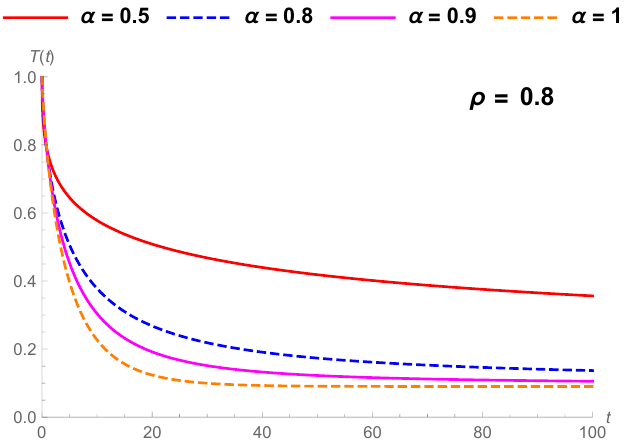
Figure 5. Comparison of drying kinetics with Lewis generalized fractional model under different α orders.